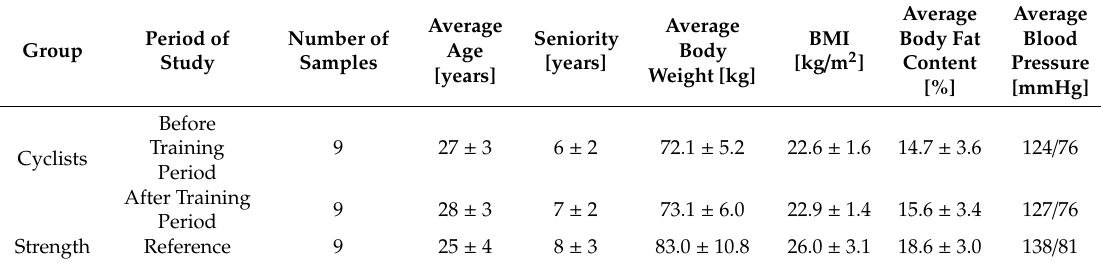
Table 1. Somatic features of athletes divided into